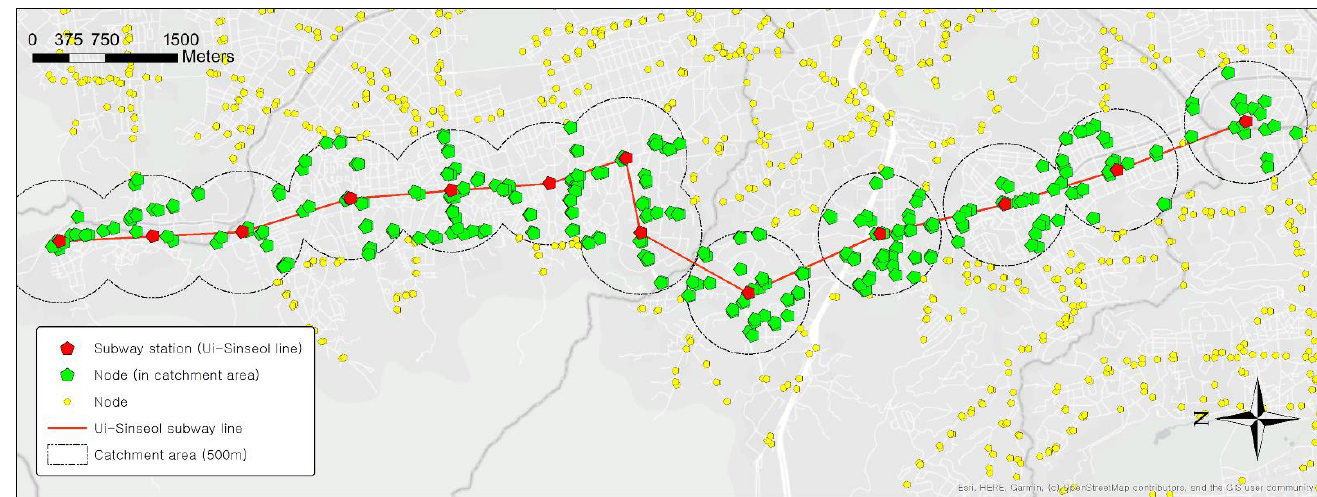
Figure 6. Map of Ui-Sinseol subway line.